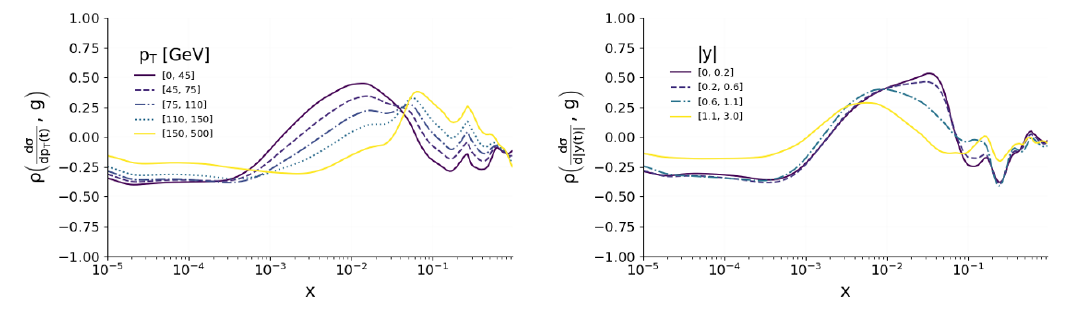
Figure 10 . Same as (cid:12)gure 9 but for the absolute ATLAS 7 TeV di(cid:11)erential measurement of the top- quark transverse momentum (left panel) and the absolute ATLAS 7 TeV di(cid:11)erential measurement of the top-quark rapidity (right panel). Both panels show the correlation coe(cid:14)cient for the gluon. The items in the legend indicate the bins that each of the lines corresponds